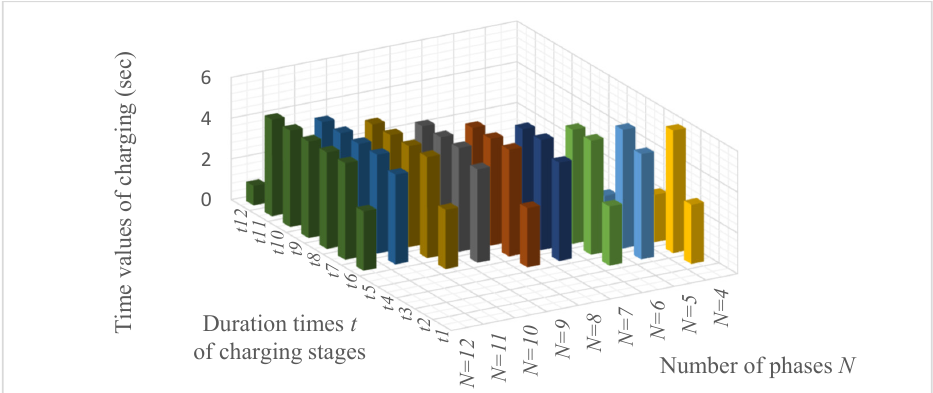
Figure 12. Comparison of times needed to charge the SC circuit from the initial voltage to the voltage at which switching to the next D 0 n is performed for different numbers of phases N .